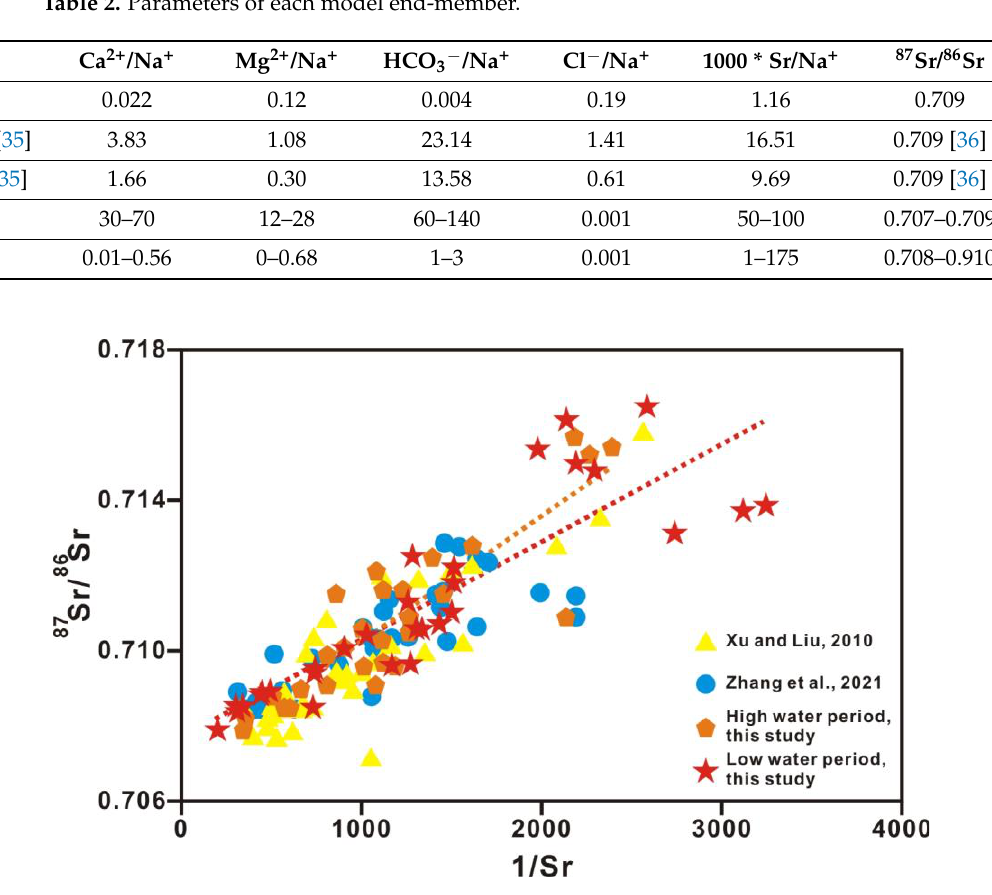
Figure 4. The relationship between 87 Sr/ 86 Sr and 1/Sr in dissolved water samples in the Xi River Basin. The orange dashed line indicates the trend line between 1/Sr and 87 Sr/ 86 Sr during the high- water period. The red dashed line indicates the trend line between 1/Sr and 87 Sr/ 86 Sr during the low- water period. Refs. (Xu and Liu, 2010; Zhang et al., 2021) are cited in figure [10,22].